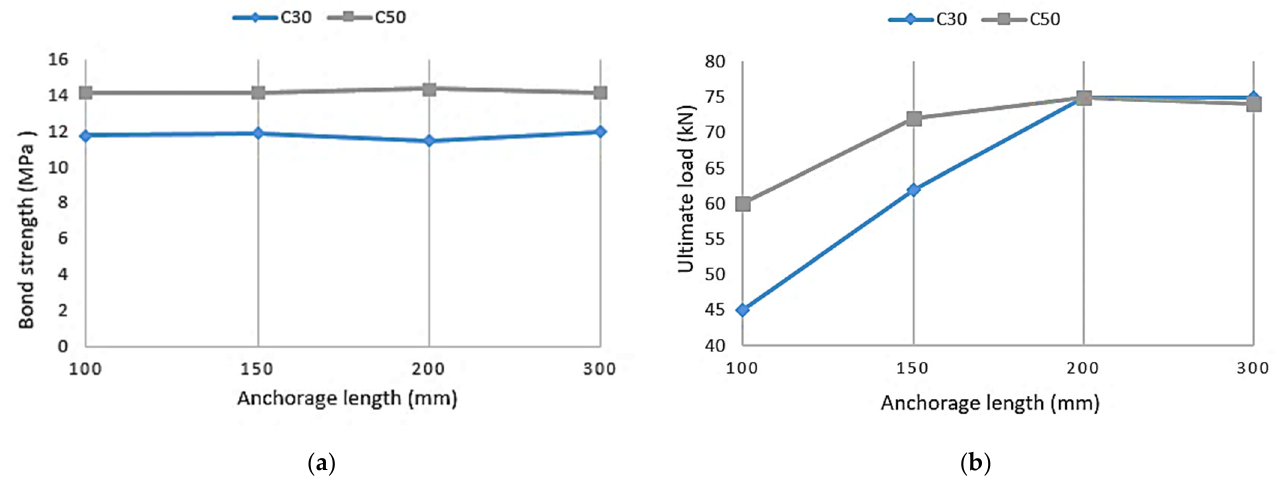
Figure 12. The e ff ect of anchorage length on the ( a ) bond strength ( b ) ultimate load